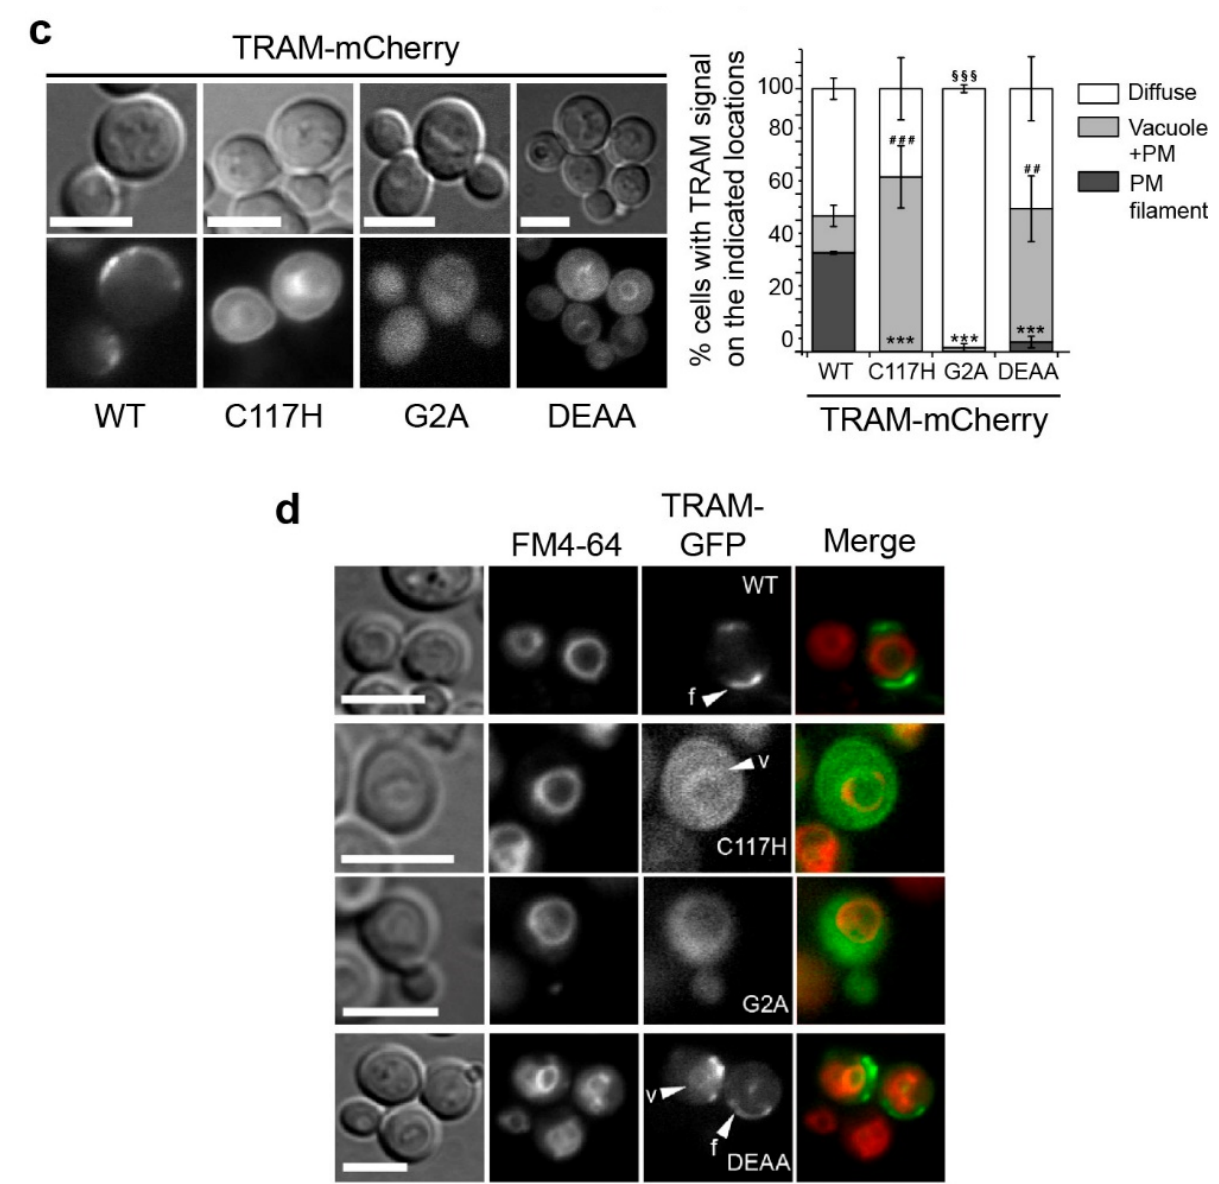
Figure 3. The TRAM adaptor forms long PM-tethered filaments when expressed in yeast. Confocal images of YPH499 yeast cells expressing TRAM-mCherry alone from a pYES3 derivative plasmid ( a ) or co-expressing it with the PtdIns(4,5)P 2 marker GFP-PH(PLC δ ) (PH-PLC) from pRS426 ( b ). In ( a ) Z-stacks are the projection of 19 planes (0.25 µ m per step). In ( b ), five representative confocal planes and the corresponding Z-stack are shown. The histogram depicts arbitrary units of fluorescence intensity vs. distance in pixels from the line distance a to b marked in the middle plane, as indicated. ( c ) Differential interference contrast and fluorescence microscopy of YPH499 yeast cells bearing WT TRAM-mCherry and the indicated mutants, expressed from pYES3 derivative plasmids (left); and a graph displaying the percentage of yeast cells showing TRAM-mCherry signal on either PM filaments, vacuoles, or diffuse in the cytosol (right). Data correspond to means ± standard deviation of three independent transformants ( n > 100). Normality was checked by the Shapiro–Wilk test. One-way ANOVA statistical comparison of filament data led a p -value < 0.001 (***) for the WT vs. the other three mutants: C117H [ p = 8.8 × 10 − 10 ], G2A [ p = 8.8 × 10 − 10 ], and DEAA [ p = 2 × 10 − 9 ]. One-way ANOVA statistical comparison of vacuole data led a p -value < 0.001 (###) for WT vs. C117H [ p = 5.3 × 10 − 4 ], and a p = 0.00575 (##) for WT vs. DEAA. One-way ANOVA statistical comparison of cytosol data led a p -value < 0.001 (§§§) for WT vs. G2A [ p = 6.8 × 10 − 4 ]. ( d ) Differential interference contrast and fluorescence microscopy of YPH499 yeast cells bearing TRAM-GFP and the indicated mutants, from YCpLG plasmid derivatives, after 1h treatment with the FM4-64 vital dye. White arrows indicate TRAM on vacuolar membranes (v) or filaments (f). All scale bars correspond to 5 µ